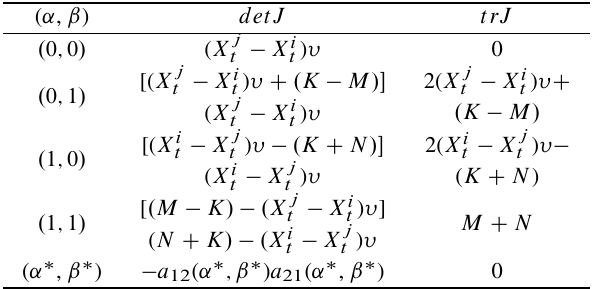
Table 2 Determinant and trace values.